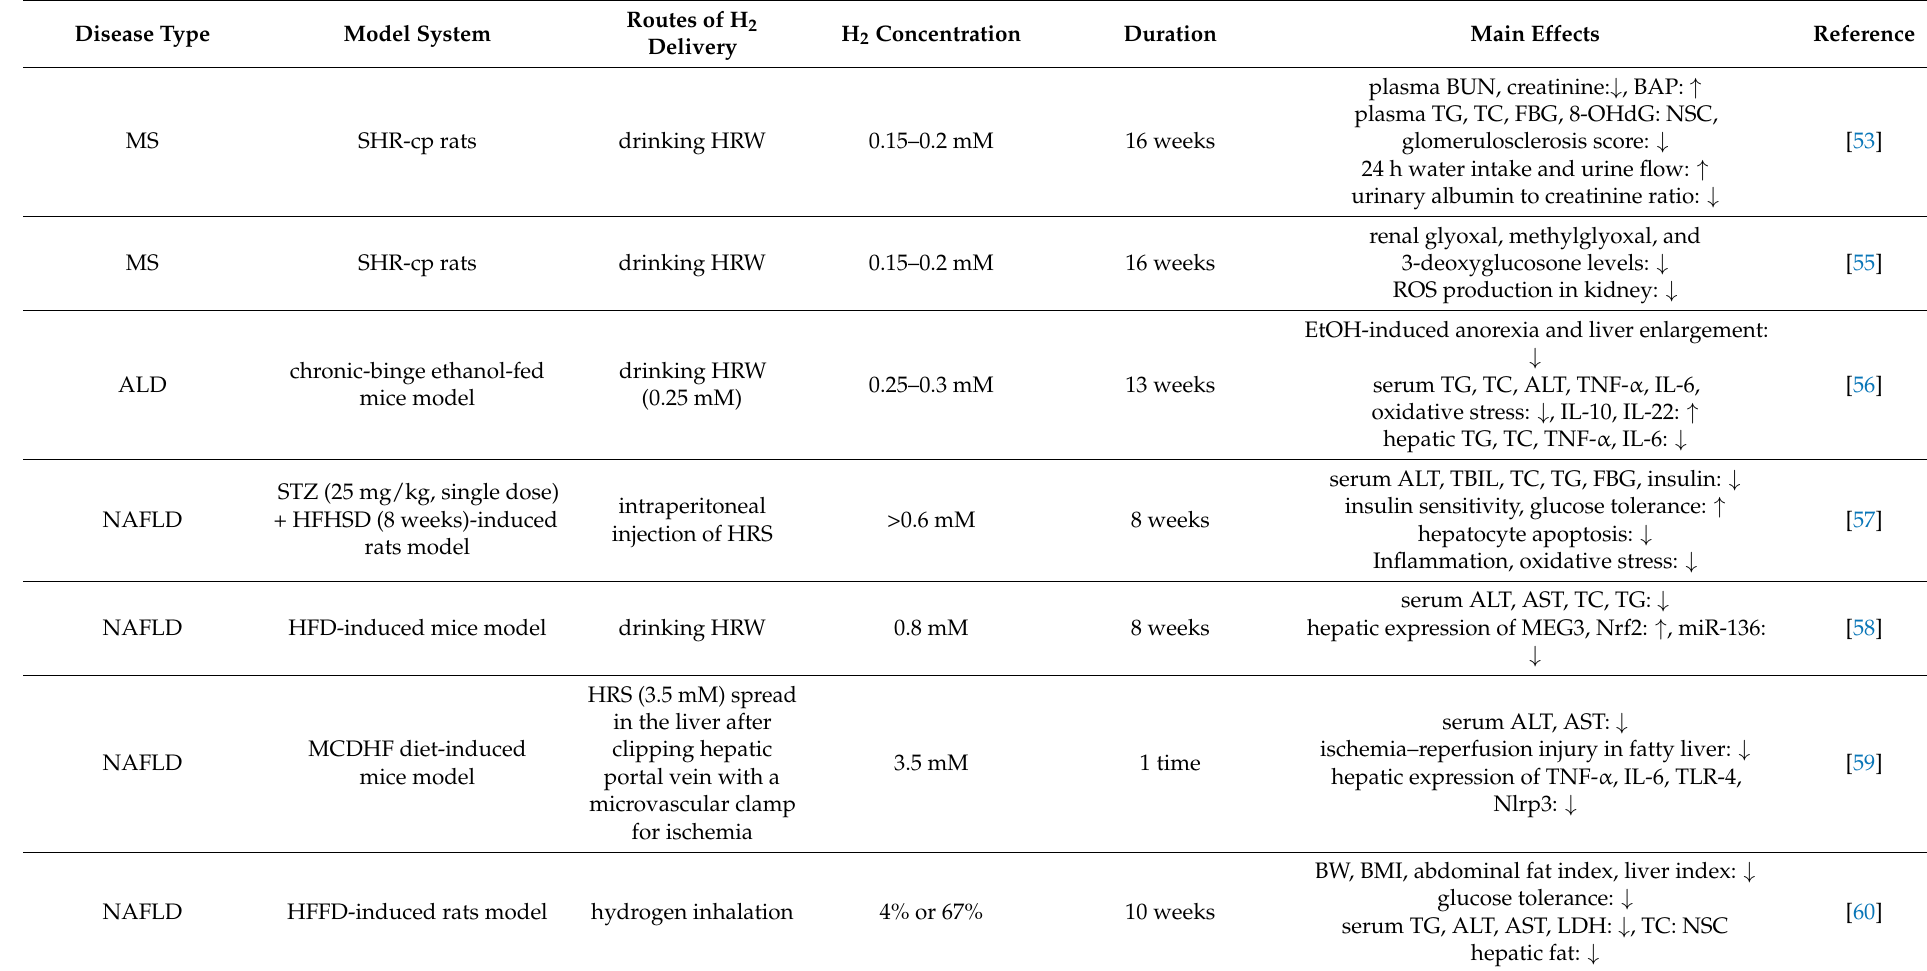
Table 3. The effects of H 2 intervention on MS, FL, AS, and